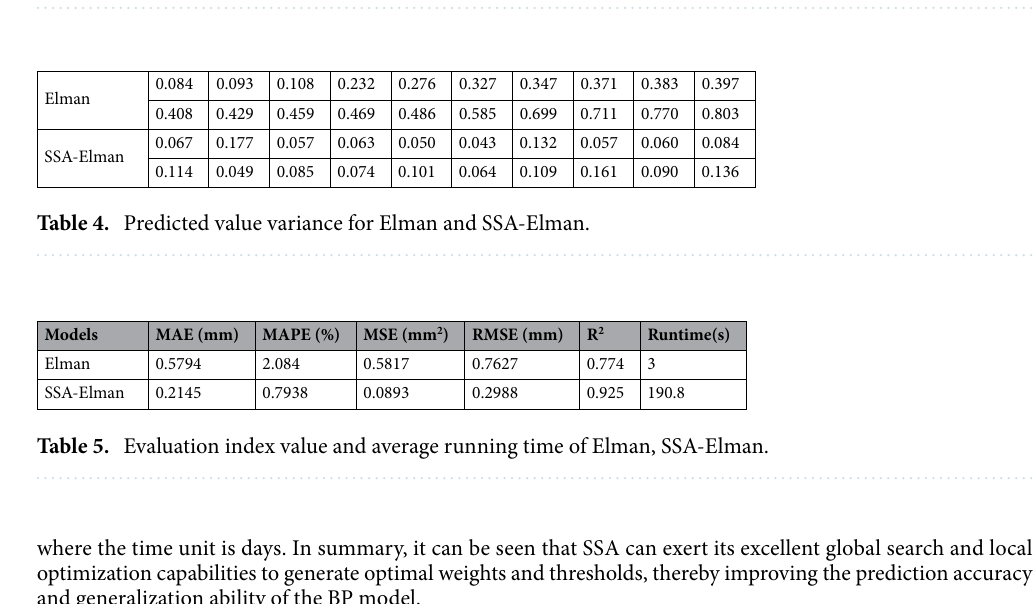
Figure 9. Comparison of Elman, SSA-Elman predicted and measured values.